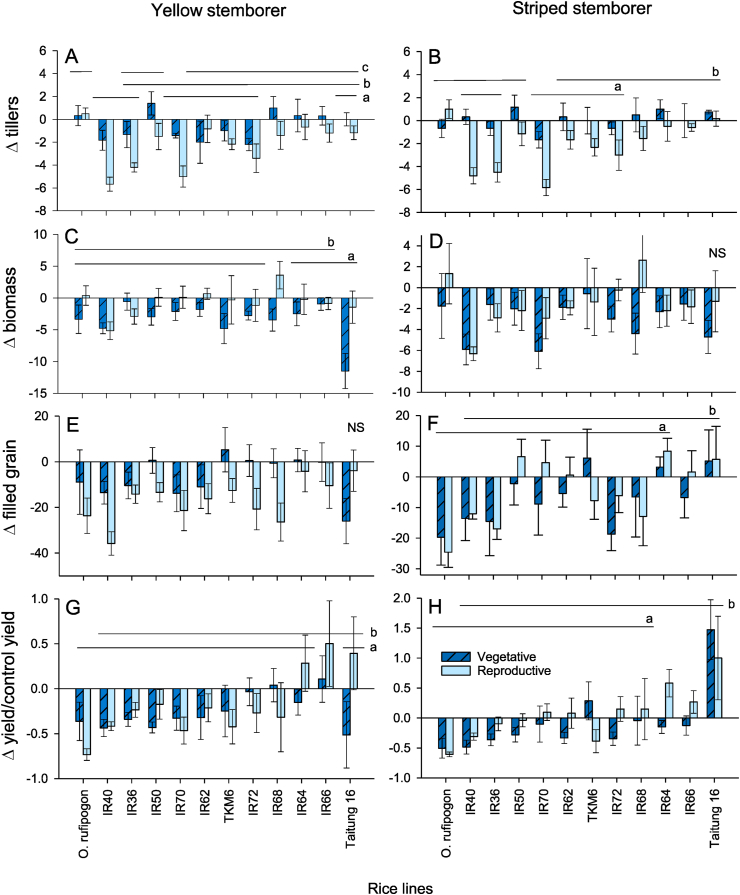
Differences between infested and non-infested, control plants (Δ) in the number of tillers (A,B), the above ground biomass (C.D), and the proportion of rice grain that was filled (E, F) for experiments with YSB (A, C, E) or SSB (B,D,F) in the greenhouse study. Proportional losses in yield (g dry weight) are also indicated for YSB (G) and SSB (H). Error bars are indicated; lowercase letters indicate homogenous rice line groups based on combined data from both plant stages and both stem borer species (Tukey > 0.05; N = 6). For further details see Table S2.